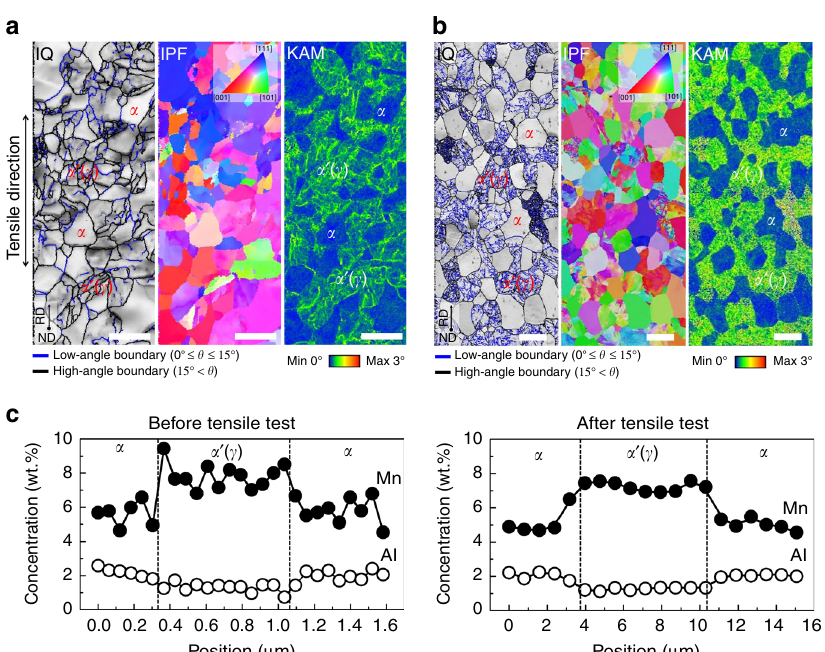
Fig. 2 SEM-EBSD images of Fe-6.6Mn-2.3Al (wt.%) specimens taken before and after 1314% tensile deformation at 850 °C with a strain rate of 1.0 × 10 − 3 s − 1 . EBSD IQ, IPF, and KAM maps of the specimens; a Before the tensile test. Scale bar , 2 μ m. b After the tensile test. Scale bar , 10 μ m. c Pro fi les of Mn and Al concentrations obtained by EDXS line scanning of α ferrite and α ′ martensite phases in the specimens before and after the tensile test. EBSD, electron back scatter diffraction; EDXS, energy dispersive X-ray spectroscopy; IPF, inverse pole fi gure; IQ, image quality; KAM, kernel average misorientation (orientation gradient measure obtained from